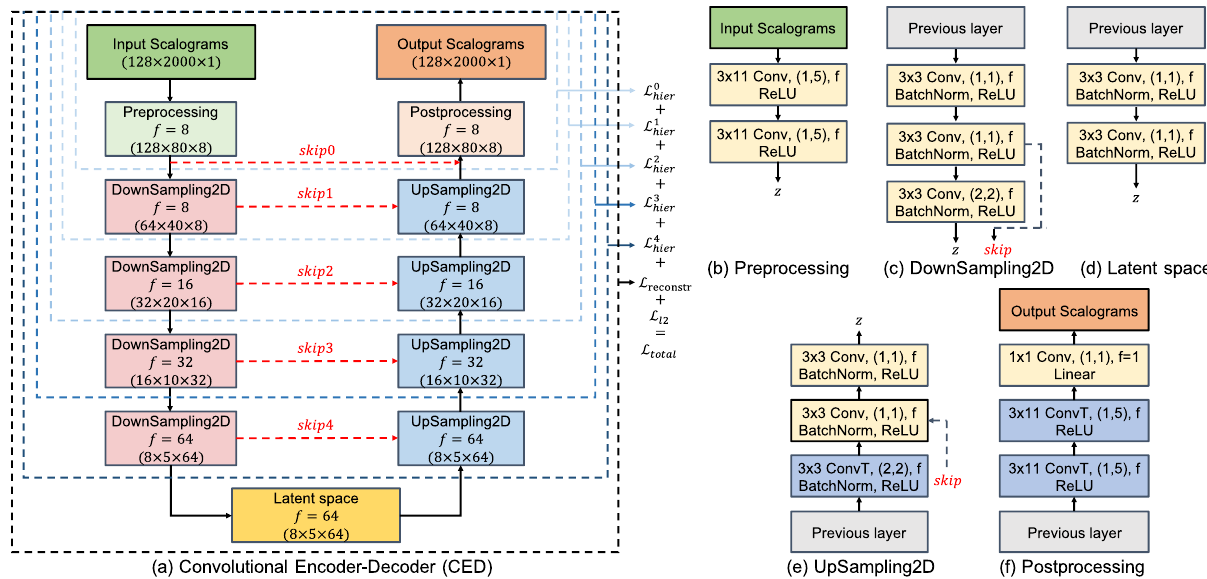
Fig. 3 The convolutional encoder-decoder (CED) model for predicting fault friction from scalograms, obtained from kinetic energy (simulation) and acoustic emission (experiment). a CED model architecture. The encoder branch contains a b Preprocessing block and c four DownSampling 2D blocks that populate the d latent space. The decoder branch reverses the procedure using e four UpSampling 2D blocks and a f Postprocessing block. The encoder and decoder models are connected by skip connections (red dashed lines) between the downsampling and upsampling blocks as shown in a . The number of fi lters ( f ) for each block are shown in a . The image size after each layer block are provided in parentheses. The blue dashed lines indicate the sub-models used when computing the hierarchical components 39 and the associated training loss function to obtain the total loss ( L total ). The model layer notations are Conv (convolutional layer), ConvT (convolutional transpose layer), BatchNorm (batch normalization layer), linear (linear connected layer), and ReLU (recti fi ed linear unit).